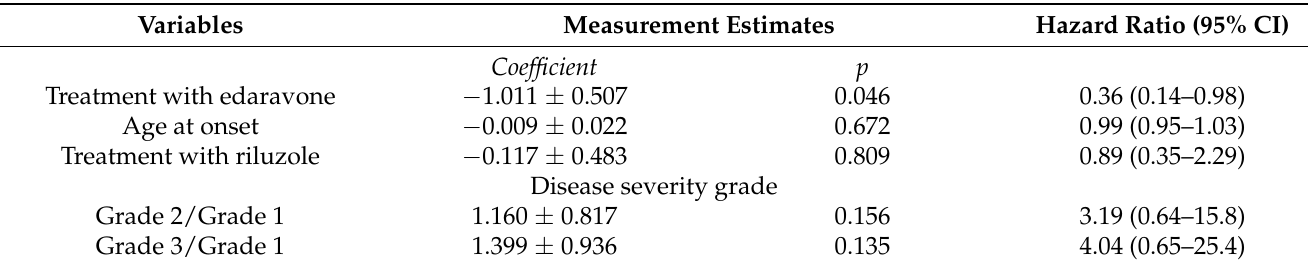
Table 2. Treatment with edaravone and subsequent hazard of death in patients with ALS: Multivariate analysis ( n = 45). Variables